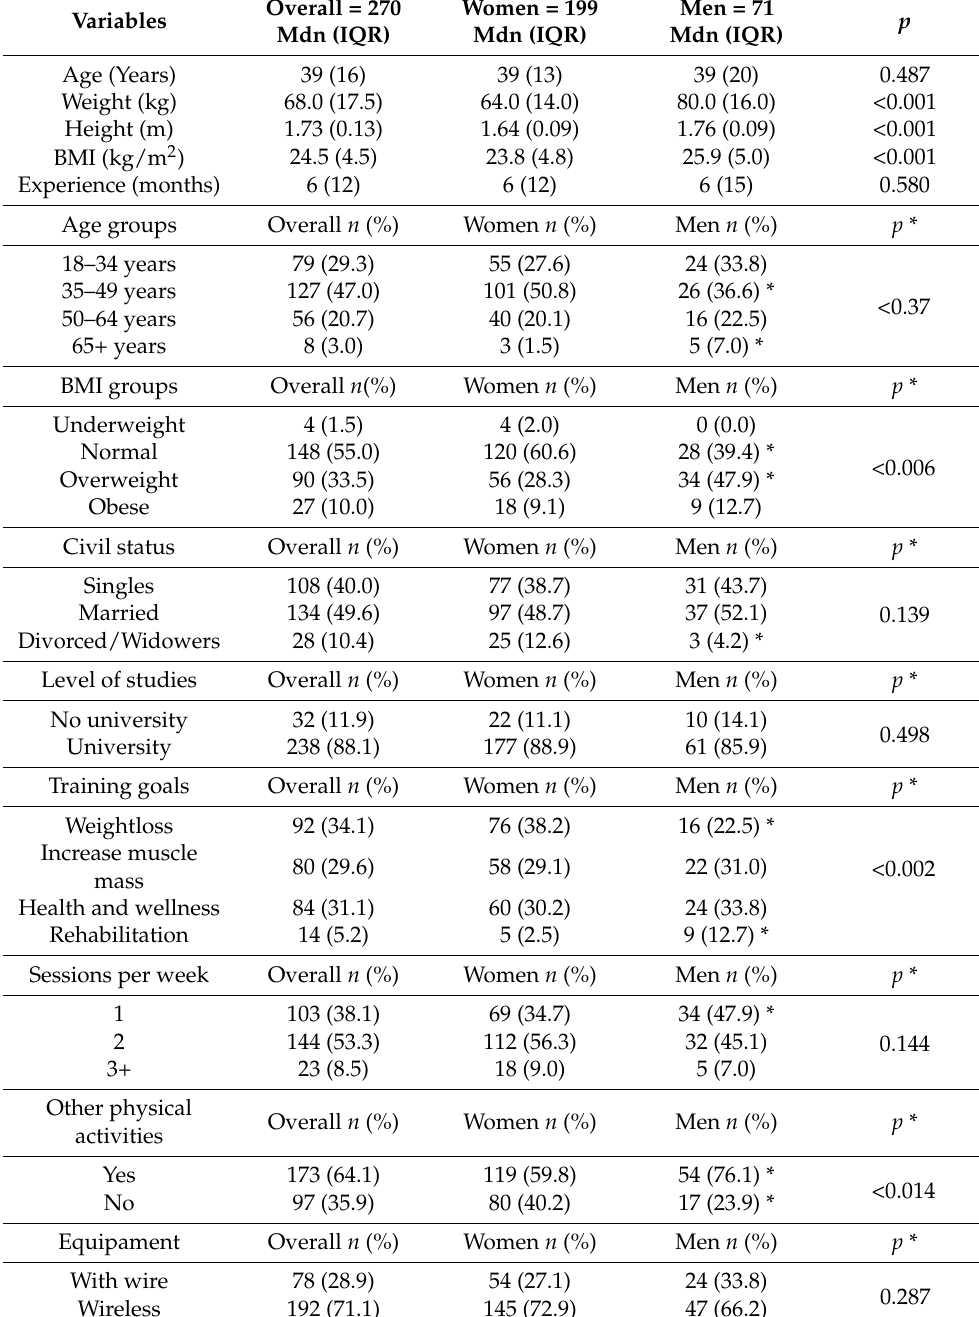
Table 1. Descriptive analysis and comparation between